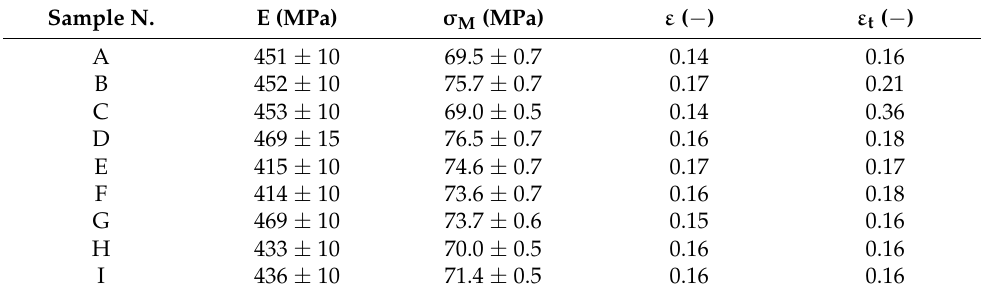
Table 3. Experimental results of tensile tests performed on specimens listed in Table 1 ( σ M is the tensile strength, ε is the tensile strain at the tensile strength, ε t is the total extension achieved at the test end).